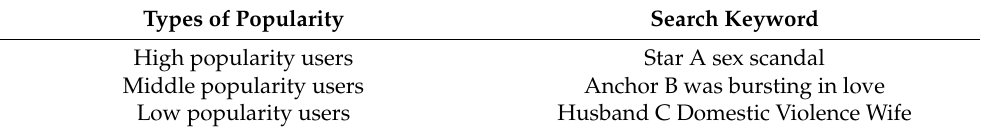
Table 5. Types of selected users and search keywords.